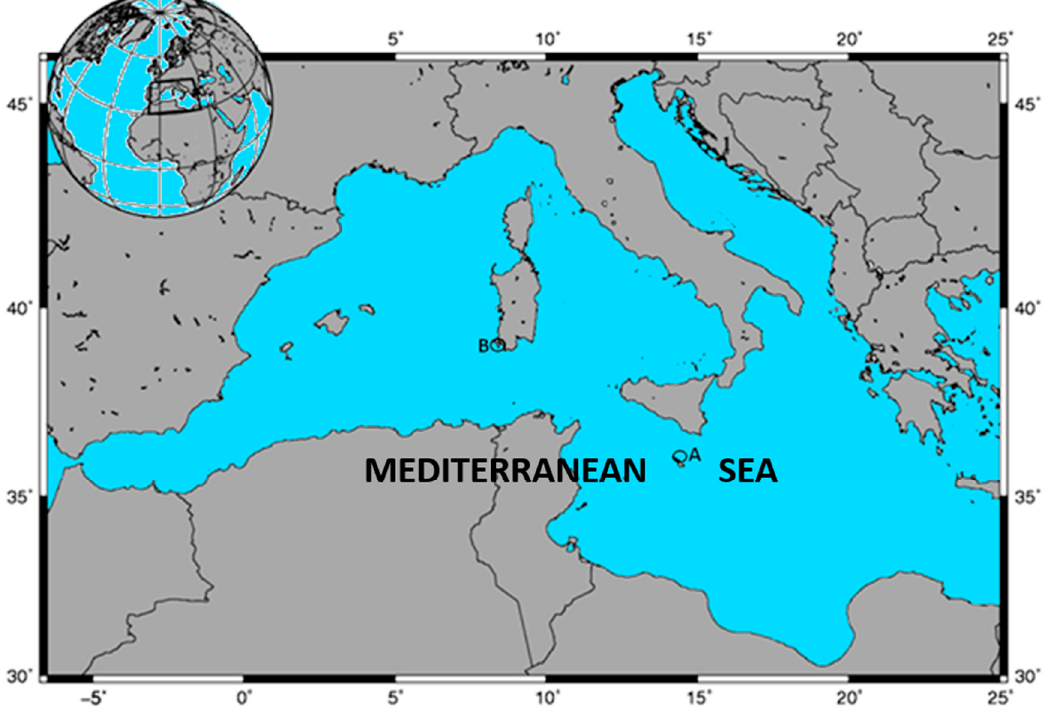
Figure 1. Map of tuna sampling in different areas of the Mediterranean Sea: ( A ), tuna farmed in fish farm Fish and Fish (Malta); ( B ), wild tuna Carloforte tonnare (Carloforte, CA, Sardinia, Italy).